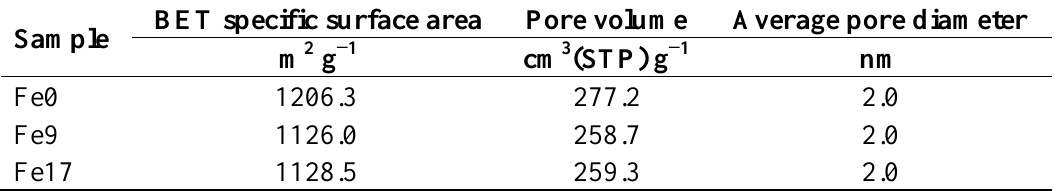
Table 1. Physical properties of activated carbons. BET = Brunauer–Emmett–Teller.